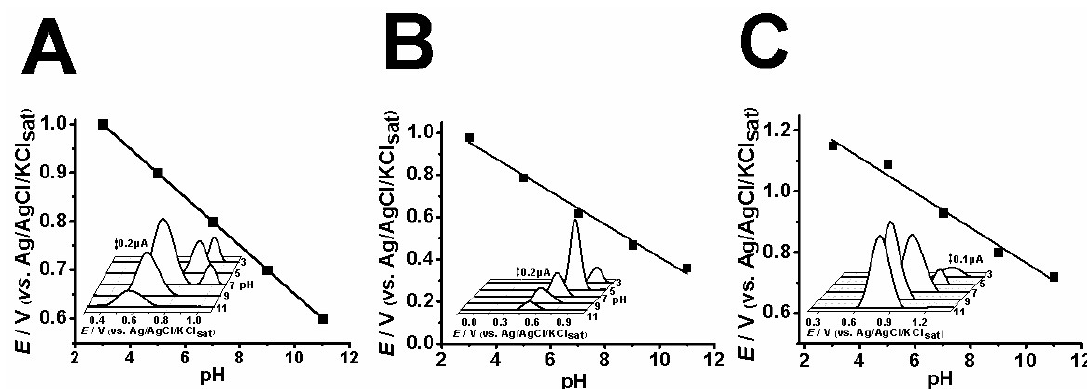
Figure 2. Differential pulse voltammetry results of 0.1 mM CBP ( A ), AMP ( B ) and NOR ( C ) at different pH levels (pH 3, 5, 7, 9, 11) in acetate buffer solution (ABS) and phosphate buffer solution (PBS).